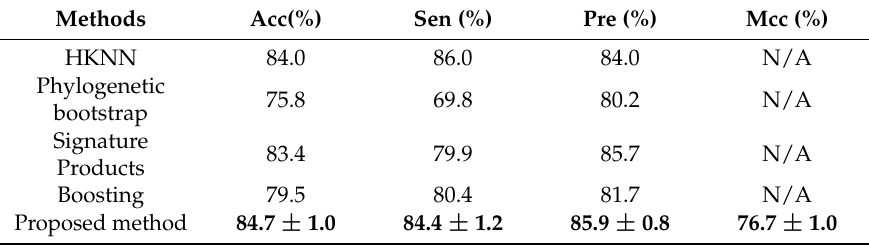
Table 3. The prediction ability of the different methods on the Helicobacter pylori protein–protein interactions (PPIs)